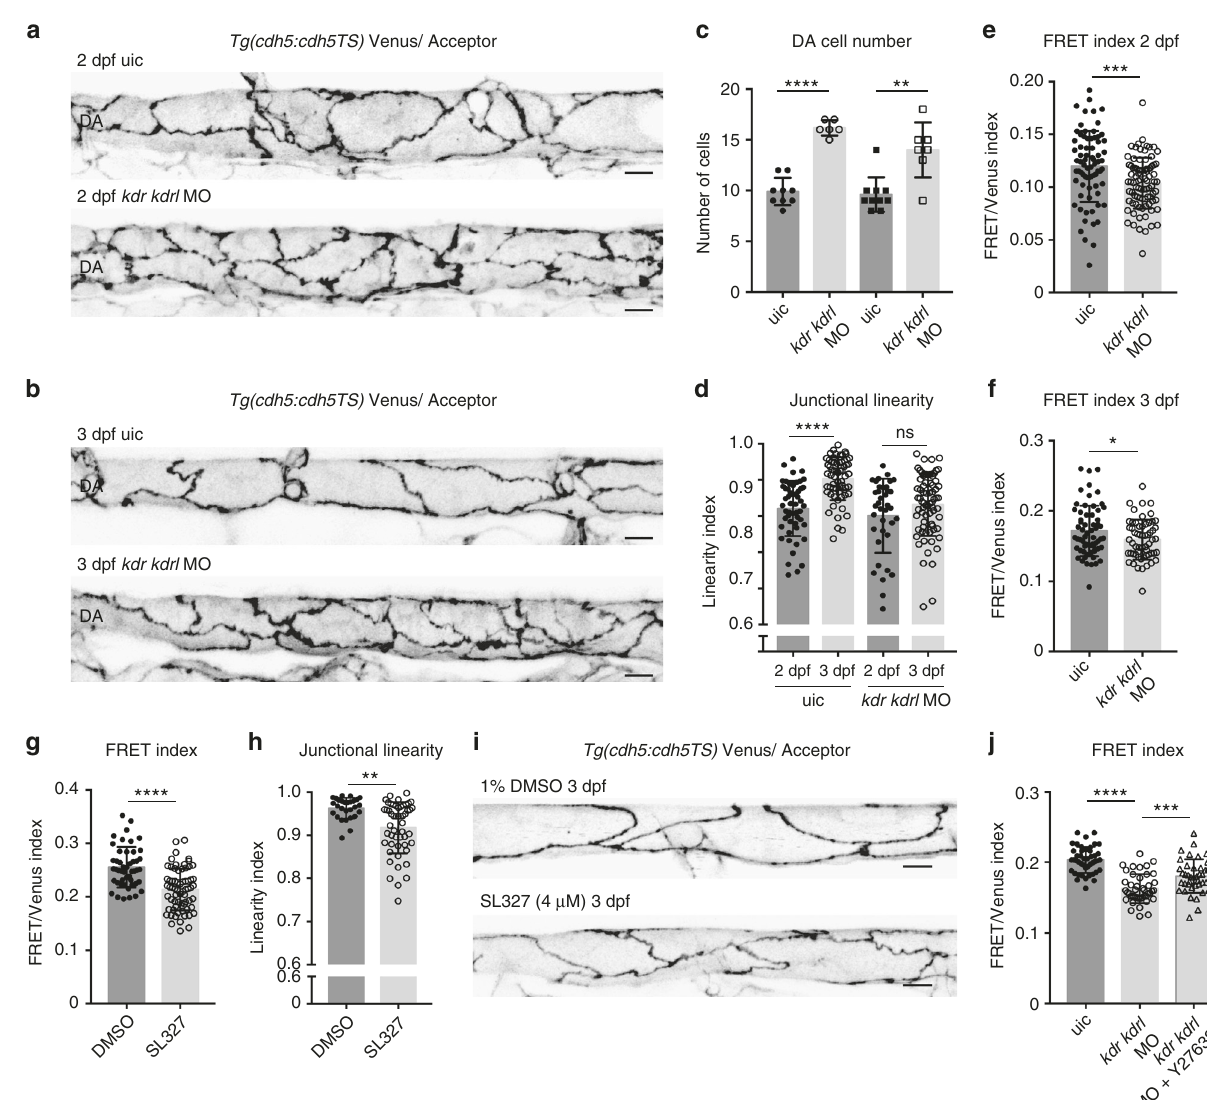
Fig. 4 Inhibiting Vegf signaling impairs linearisation and VE-cadherin tension changes during arterial maturation. ( a , b ) Junctional morphology of ECs in the DA (Venus, grey) in uic (top) and kdr / kdrl morphants (bottom) at 2 dpf ( a ) and 3 dpf ( b ). Scale bar = 10 μ m. c Number of ECs quanti fi ed at 2 dpf (uic n = 9, kdr/kdrl MO n = 6 embryos) and 3 dpf (uic n = 10, kdr/kdrl MO n = 7 embryos). Error bars represent mean ± s.d.; 2 dpf uic – 2 dpf kdr / kdrl MO **** p < 0.0001 from unpaired two-sided t test, 3 dpf uic – 3 dpf kdr / kdrl MO ** p = 0.0068 from unpaired two-sided Mann – Whitney test. d Junctional linearity index of junctions in uic and kdr / kdrl morphants at 2 dpf and 3 dpf. Error bars represent mean ± s.d.; 2dpf uic – 3dpf uic **** p < 0.0001; 2 dpf kdr / kdrl MO – 3dpf kdr / kdrl MO, p = 0.0862 from unpaired two-sided Mann – Whitney test. e , f Ratio-metric FRET values of uic and kdr / kdrl morphants at 2 dpf e (uic n = 74 junctional ROIs from n = 9 embryos, kdr / kdrl MO n = 86 junctional ROIs from n = 6 embryos) and 3 dpf f (uic n = 62 junctional ROIs from n = 10 embryos, kdr / kdrl MO n = 58 junctional ROIs from n = 7 embryos). Error bars represent mean ± s.d.; *** p = 0.0007; * p = 0.0391 from unpaired two-sided t test. g Ratio-metric FRET values from 1% DMSO controls ( n = 48 junctional ROIs from n = 6 embryos) versus SL327 (4 μ M/1% DMSO)-treated embryos ( n = 66 junctional ROIs from n = 10 embryos). Treatment from 20 hpf to 3 dpf. Error bars represent mean ± s.d.; **** p < 0.0001 from unpaired two-sided t test. h Junctional linearity index in 1% DMSO treated controls ( n = 32 junctional ROIs from n = 6 embryos) versus SL327 (4 μ M/1% DMSO)-treated embryos ( n = 56 junctional ROIs from n = 10 embryos). Error bars represent mean ± s.d.; ** p = 0.0045 from unpaired two-sided Mann – Whitney test. i Junctional morphology of ECs in the DA (Venus, grey) at 3 dpf in 1% DMSO and SL327 (4 μ M/1% DMSO) treated embryos at 3 dpf. Scale bar = 10 μ m. j Ratio-metric FRET values from uic ( n = 45 junctional ROIs from n = 8 embryos) versus kdr / kdrl morphants incubated in 1% DMSO as a control ( n = 43 junctional ROIs from n = 9 embryos) and kdr / kdrl Y-27632-treated morphants (50 μ M/1% DMSO, n = 40 junctional ROIs from n = 9 embryos) at 2 dpf. Error bars represent mean ± s.d.; uic – kdr / kdrl MO + DMSO **** p < 0.0001; kdr / kdrl MO + DMSO – kdr / kdrl MO + Y-27632 *** p = 0.0005 from unpaired two-sided